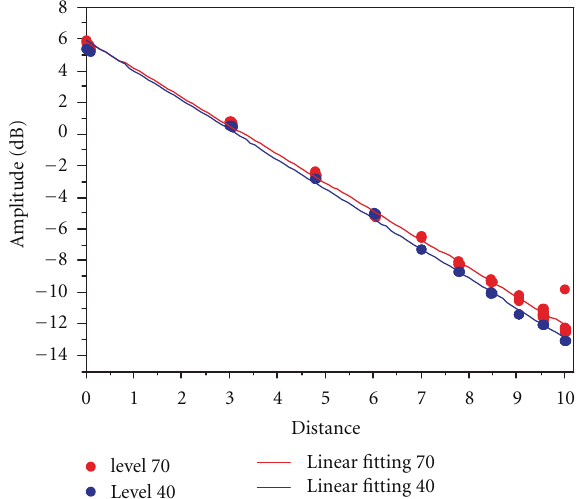
Figure 5: Path loss versus distance (LOS).